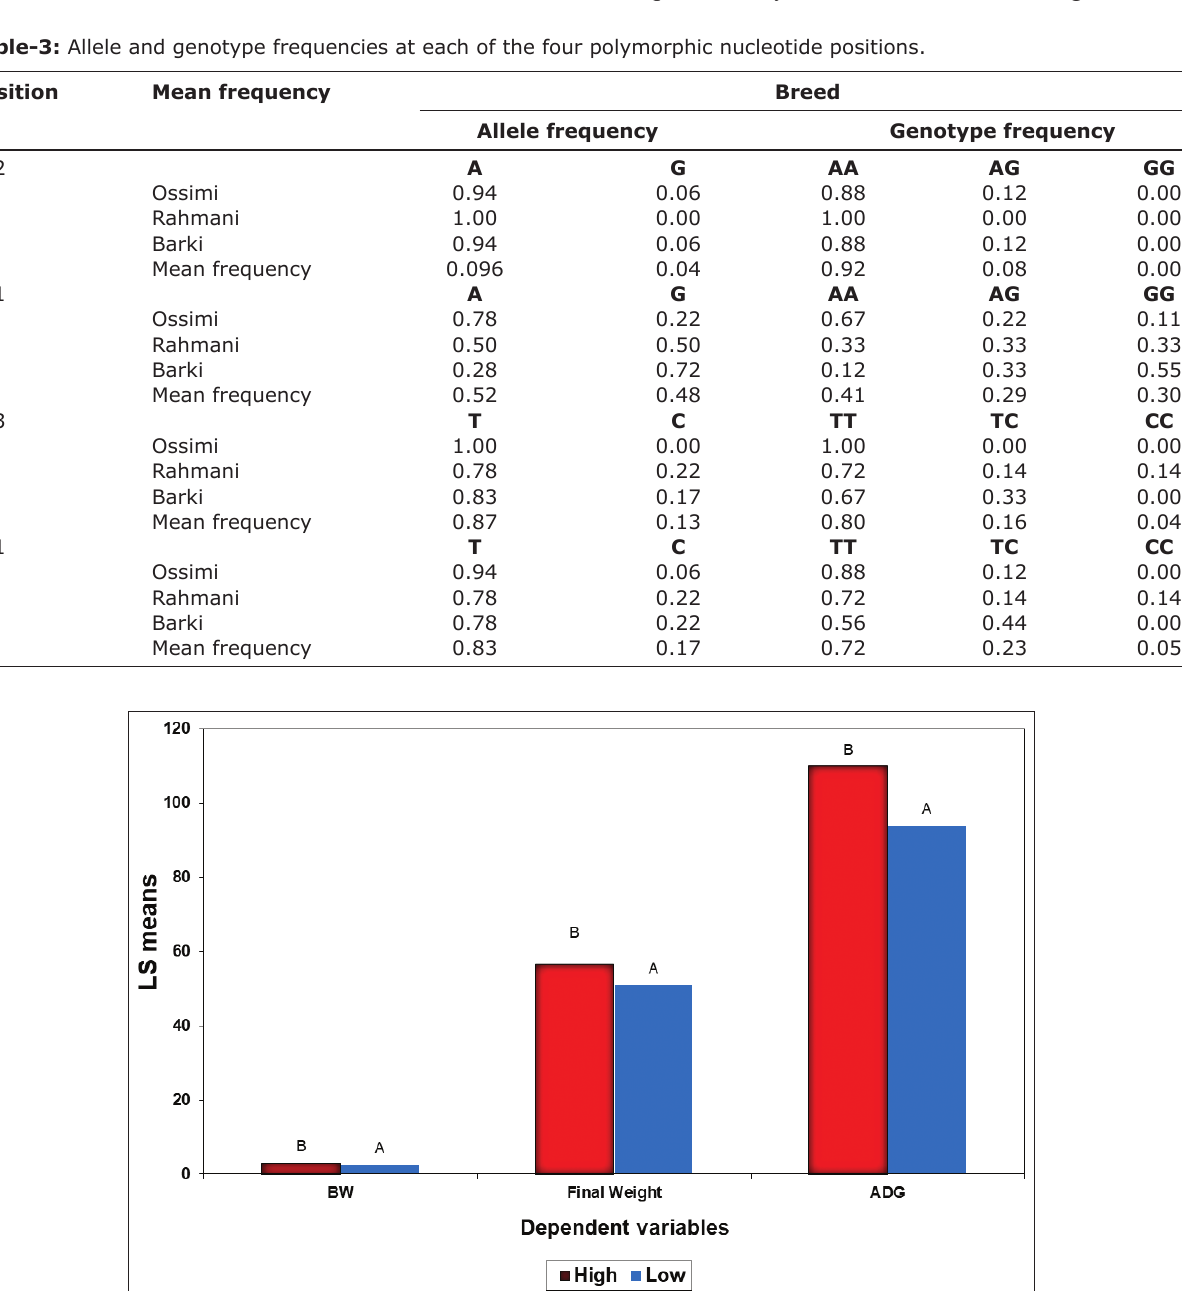
Figure-1: Differences between high and low classes in the studied traits genotyping by single-nucleotide